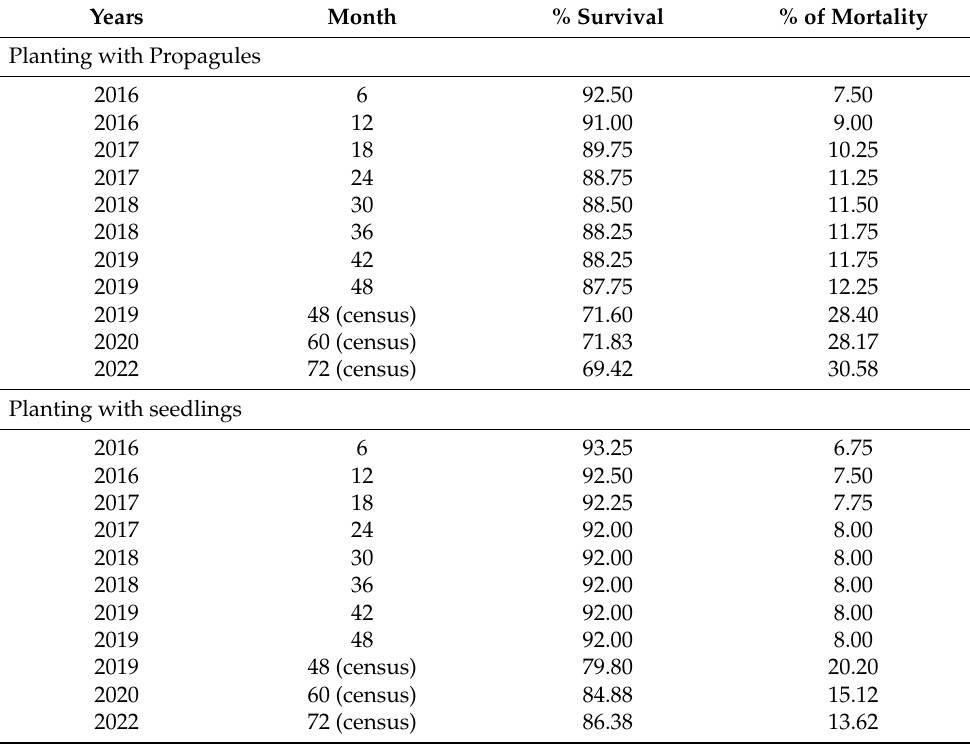
Table 11. Percentage of plant survival and mortality between 6–48 months (2016–2019) of individual observation and followed by plant census for the remaining period up to 2022 or 7 years old. Years Month % Survival % of Mortality Planting with Propagules